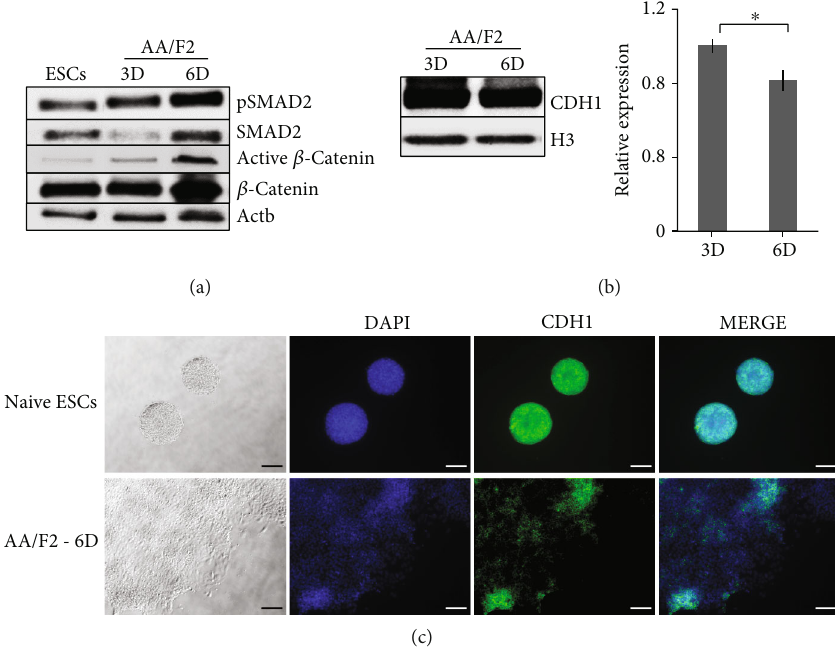
Figure 3: Epithelial-mesenchymal transition occurs during maturation to the PS-like state. (a) Western Blot analysis of the markers involved in WNT and TGF β signaling pathways in the indicated samples (relative quanti fi cation graph: Figure S2A). Activin/nodal (pSMAD2) and WNT (active β -catenin) signaling were highly active by 6 days of AA/F2 treatment, compared to 3 days. Actb: control. (b) Western blot analysis of the epithelial marker CDH1 protein in the indicated samples. Histone H3 (used for normalization) and Actb (Figure S2D) served as controls. There was a slight decrease in the expression of CDH1. Error bars: mean ± SD ( n = 2 ); ∗ p ≤ 0 : 05 ; p ð CDH1 Þ = 0 : 0471 (Student ’ s t -test). (c) Representative immunostainings of the indicated proteins in the cells treated with AA/F2 for 6 days (scale bars 100 μ